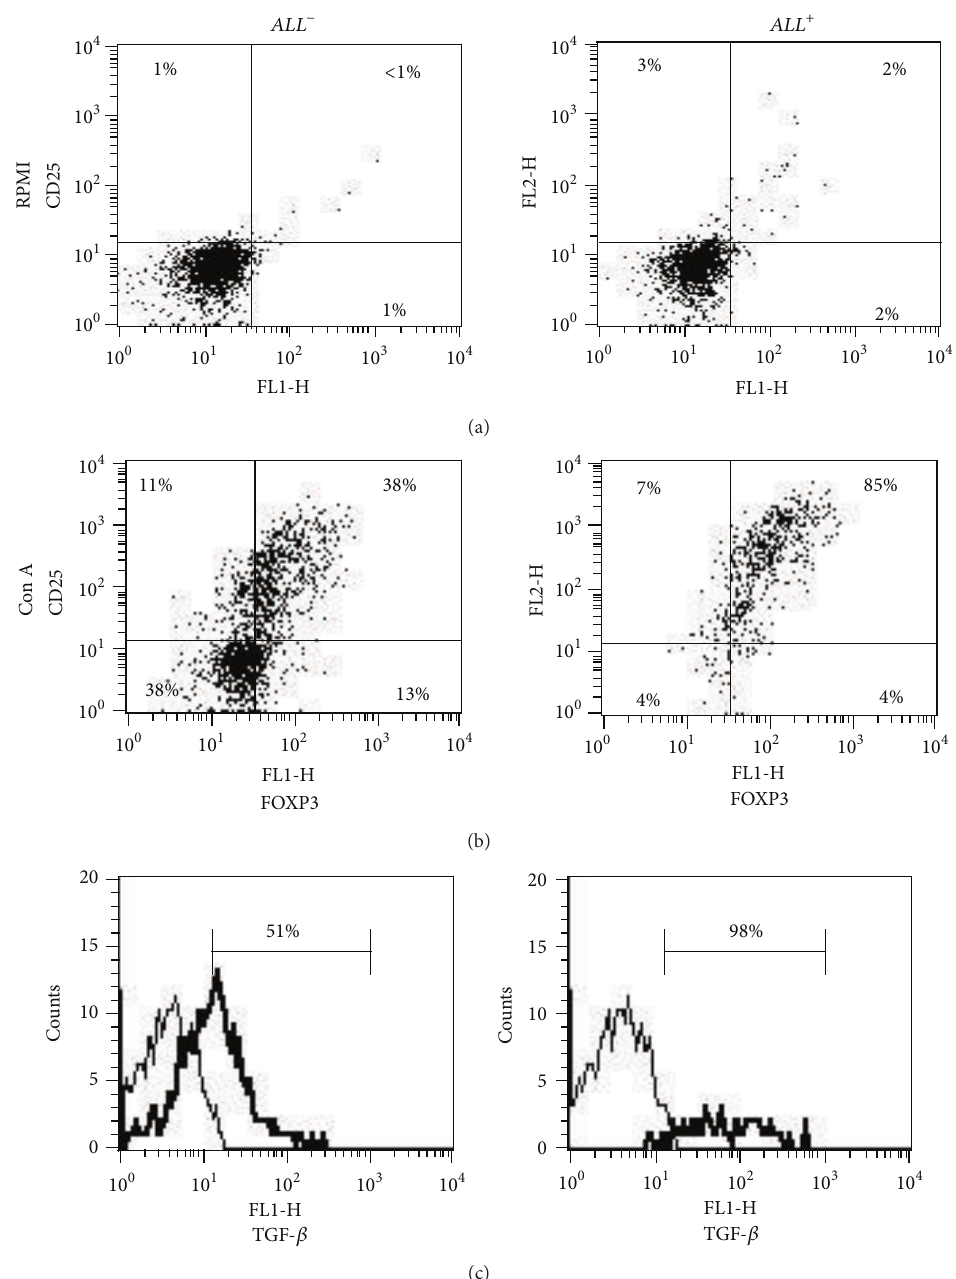
Figure 5: Polyclonal stimulation induced high expression of Foxp3 and TGF- 𝛽 in ALL + T helper cells. CD4 + T cells were stimulated with Concanavalin-A (2 𝜇 g/mL). After 48 h, cells were stained with biotin- ALL followed by CyChrome-streptavidin, and stained with monoclonal antibodies against CD25 and Foxp3 or TGF- 𝛽 . (a) Dot plots of nonstimulated cells (RPMI alone) showing frequency of CD25 + Foxp3 + in ALL − and ALL + T helper cells. After polyclonal stimulation An increased frequency of both (b) CD25 + Foxp3 + cells and (c) TGF- 𝛽 + cells (thick line) in ALL + T helper cells was observed. (Thin line corresponds to isotype control). + + as IL-10 and TGF- 𝛽 . It has been shown that CD25 CD4 Treg cells are able to produce IL-4 and IL-10, without production of IFN- 𝛾 [23]. Likewise, other authors have shown that sorted CD25 + CD4 + Treg cells produce high concentrations of IL- 10 and low IFN- 𝛾 [22]. In agreement with these data, our results suggest that ALL + T cells correspond to a Treg cell